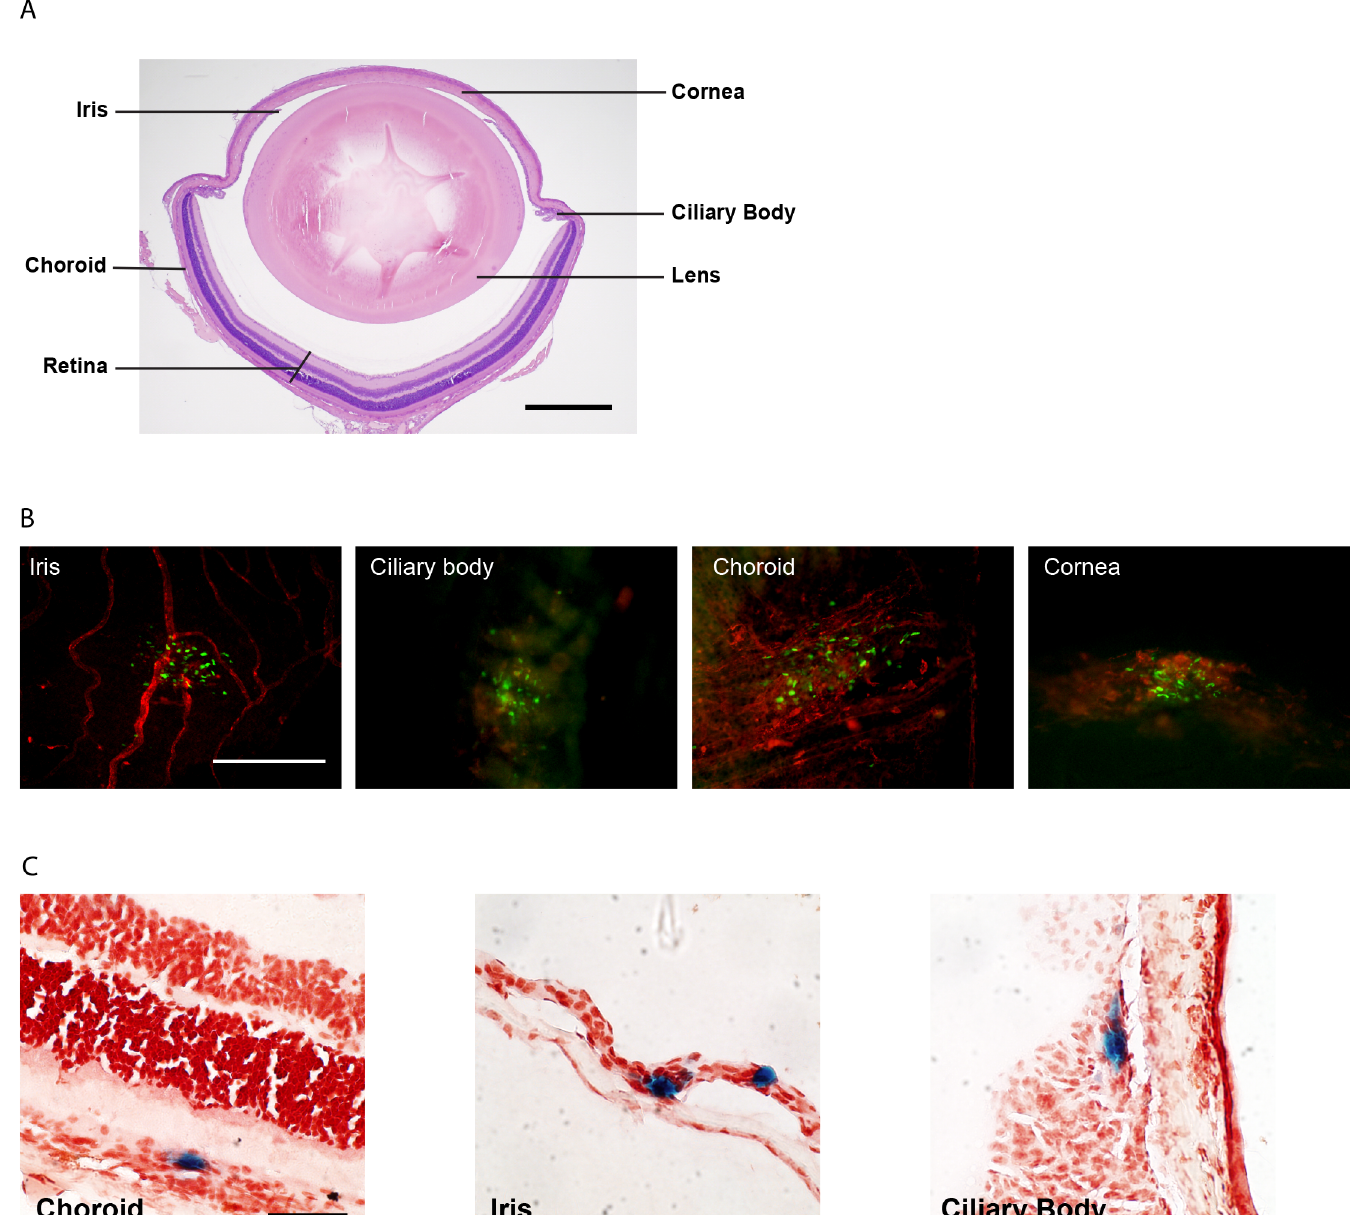
Fig 4. Defining the compartments of the eye infected by MCMV. (A) Haematoxylin and eosin stained section of an uninfected mouse eye with the major compartments labelled. Scale bar: 500 μm. (B) Eyes were removed from MCMV-infected mice at day 5 pi, components of the eye dissected and whole-mounts prepared. The samples were stained with antibodies against MHC-II (red) and IE1 (green—for viral antigen) and microscopy performed. Scale bar: 200 μm. Results are representative of at least 5 independent experiments with n (cid:21) 20. (C) Mice were infected with MCMV-LacZ and eyes removed at day 5 pi. Frozen tissue sections were prepared and stained with x-gal to identify virally infected cells (blue) and counterstained with neutral red to identify cell nuclei. Scale bar: 50